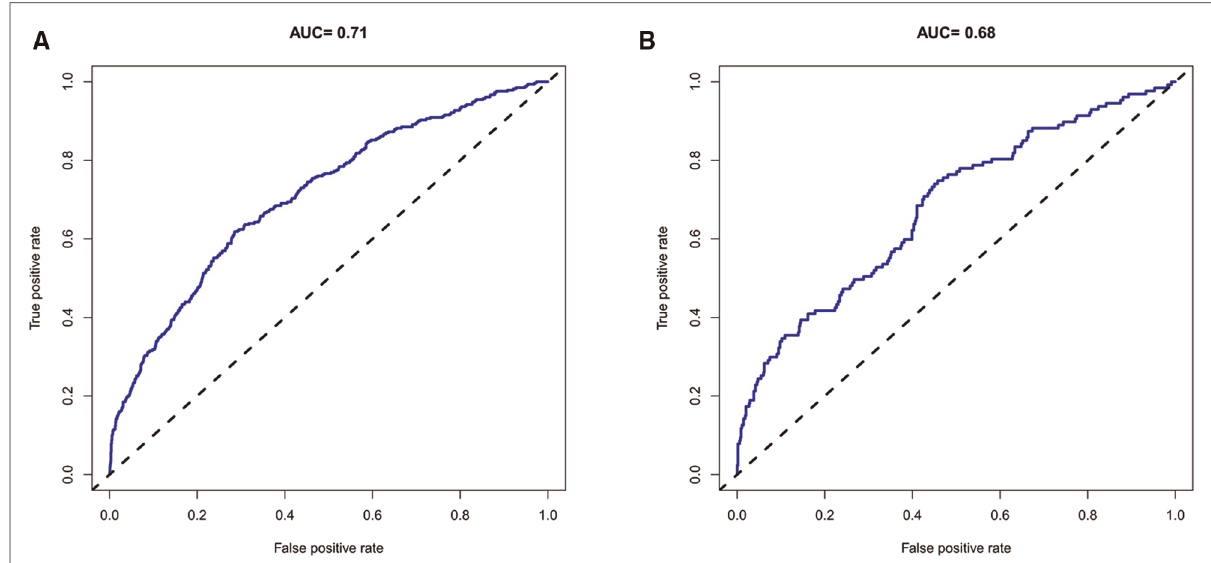
FIGURE 3 The ROC curves of prolonged hospital stay in the training set ( A ) and validation set ( B ).